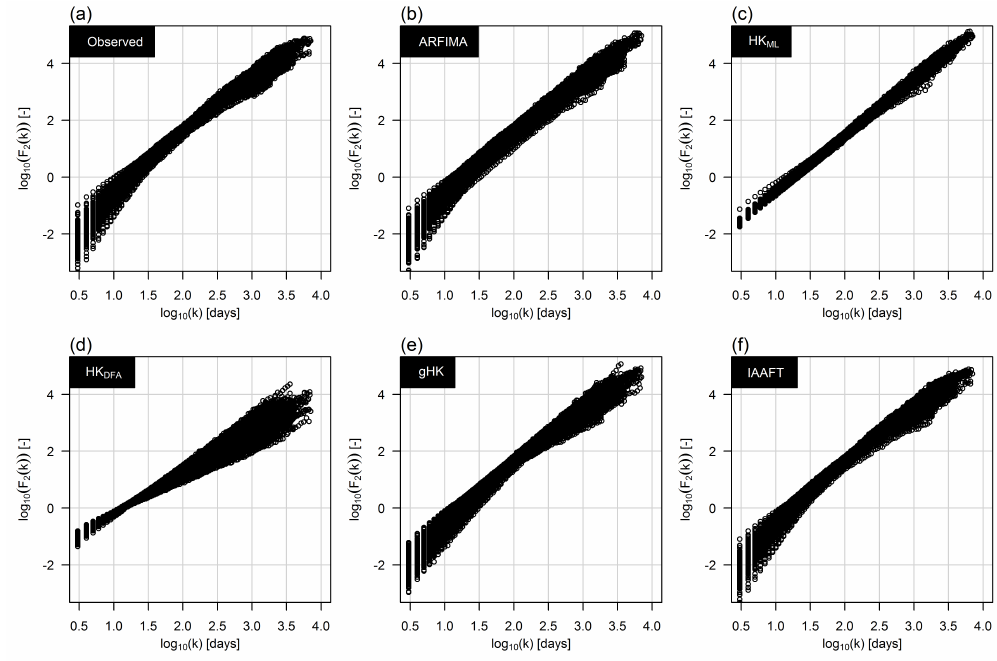
Figure 6. Variance fluctuation functions F 2 ( k ) of the 473 flow series versus the corresponding aggregation time scales k for the observed series ( a ) and sequences with the same length simulated by ARFIMA ( b ); HK ( c , d ); gHK ( e ); and IAAFT ( f ).